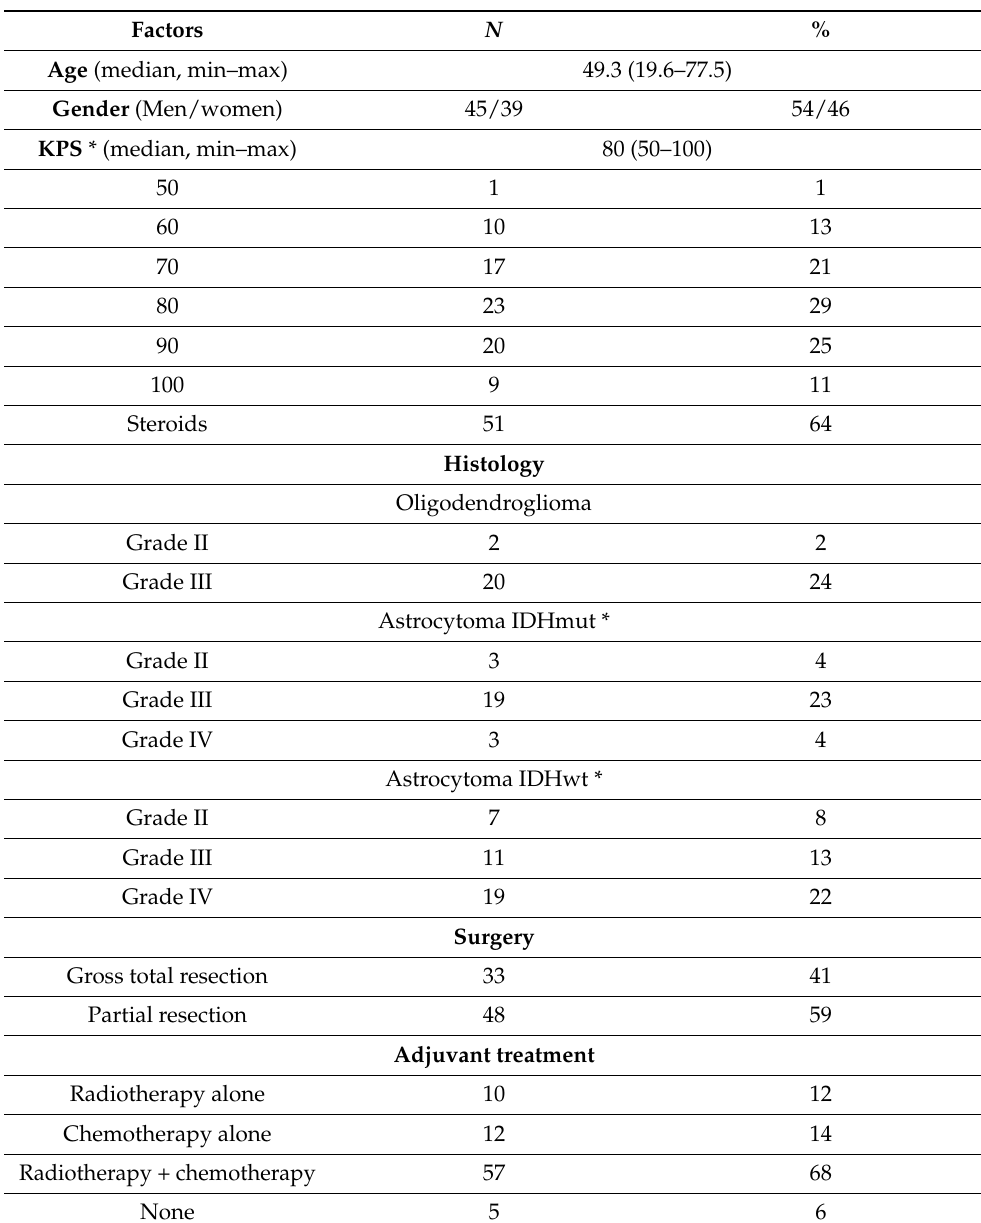
Table 1. Patient